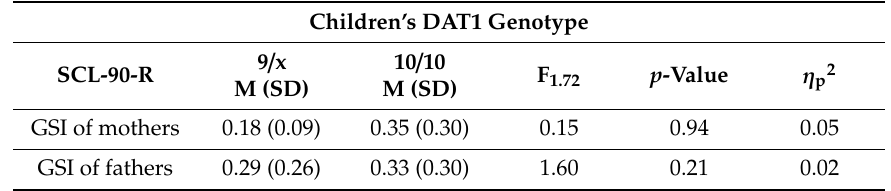
Table 4. Univariate results of the di ff erences between the two groups on parental psychopathological risk, controlling for children’s age, temperament and emotional-behavioral functioning.